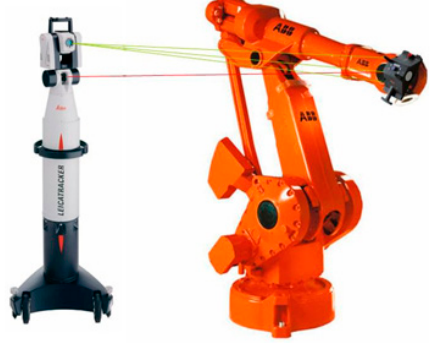
Figure 13. Laser tracker.